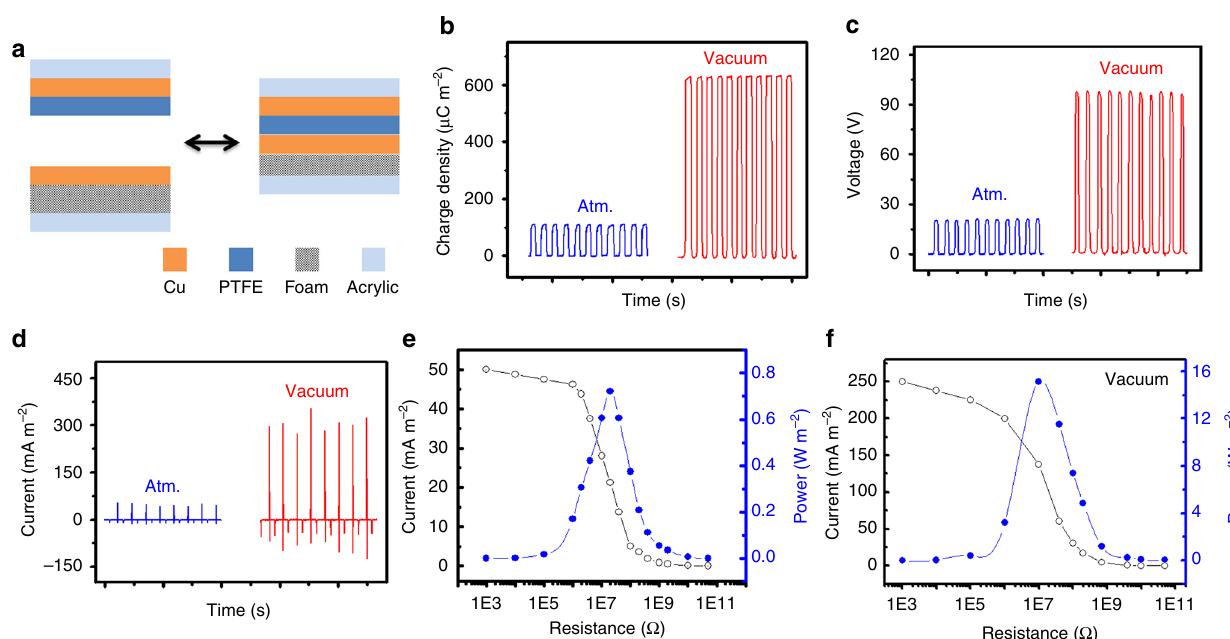
Fig. 2 Output performance of TENG in the vacuum. a Schematic of TENG with a cushioned Cu electrode to increase contact intimacy during operation process. b – d , b Charge density, c open-circuit voltage, and d short-circuit current of the TENG in atmosphere and high vacuum ( P ~ 10 − 6 torr). e , f